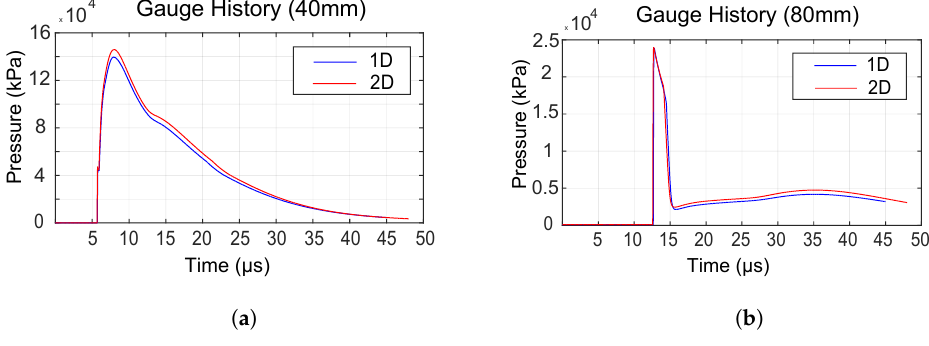
Figure 8. Convergence analysis between 1D and 2D. ( a ) Incident pressure histories at 40 mm [44], ( b ) Incident pressure histories at 80